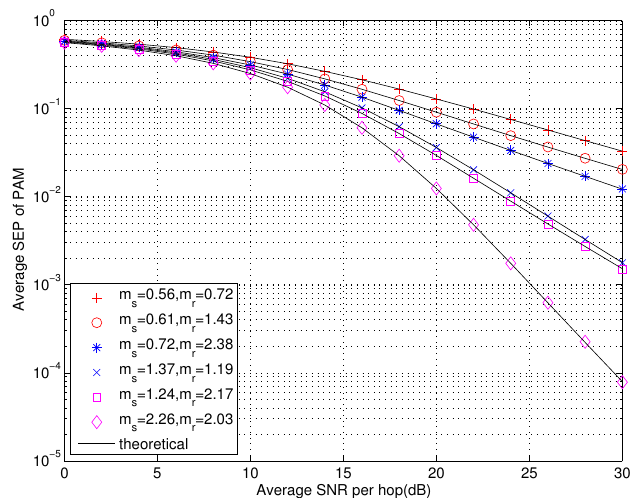
Figure 2. Average SEP of 4-ary pulse amplitude modulation (4PAM).